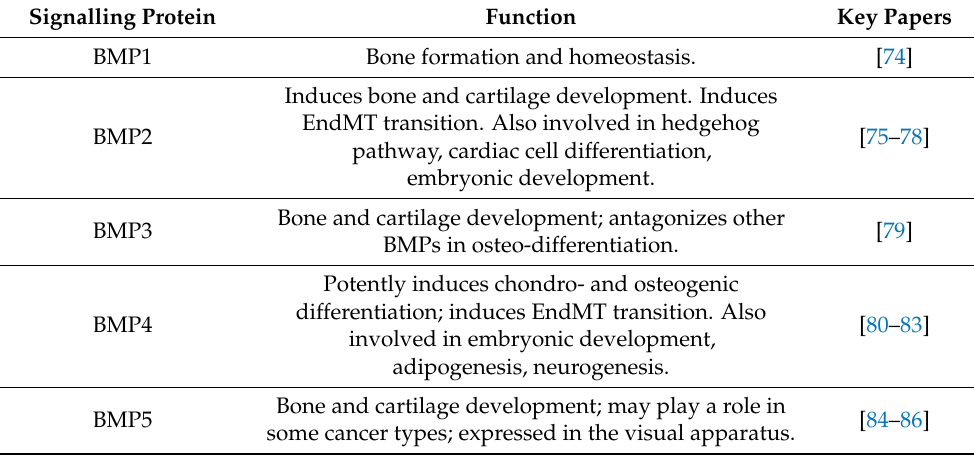
Table 2. Overview of BMPs and their role in major cellular process and heterotopic